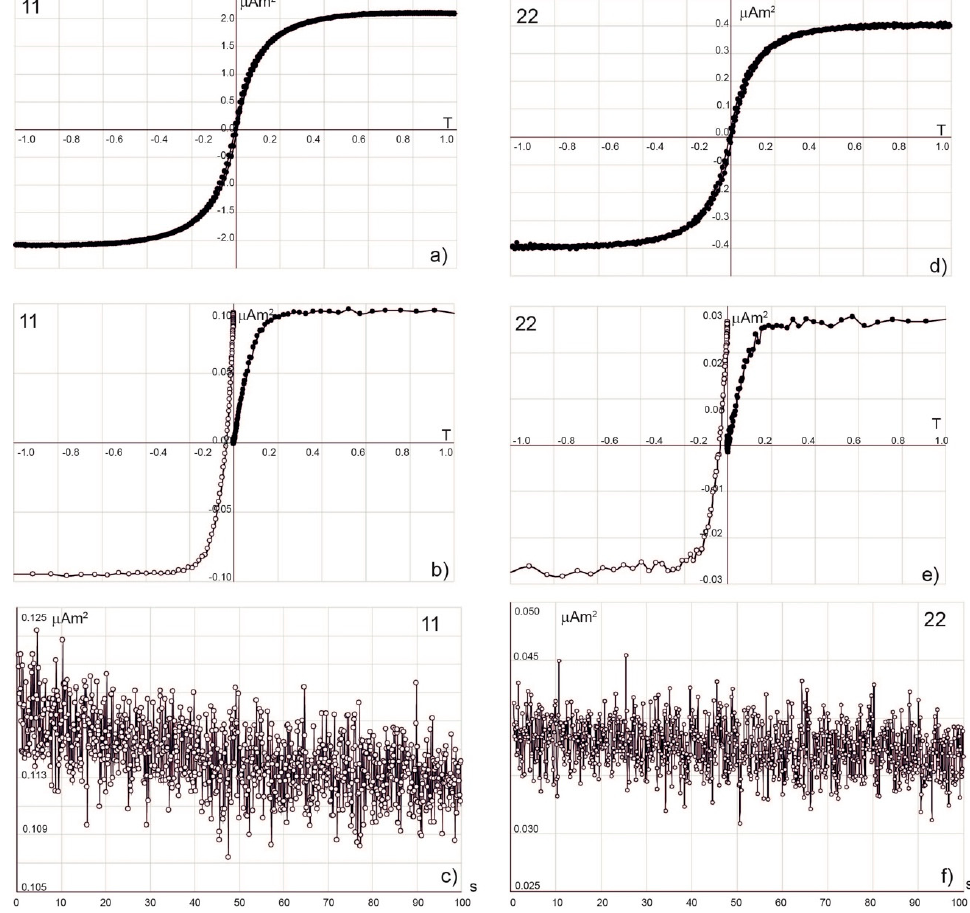
Figure 3. Hysteresis loops corrected for high-field linear trend ( a , d ), isothermal remanent magnetization and backfield application ( b , e ) and Mrs decay in 100 s ( c , f ) for samples 11 and 22, the most and the least intense of the dataset, respectively. Original data, not divided by mass.